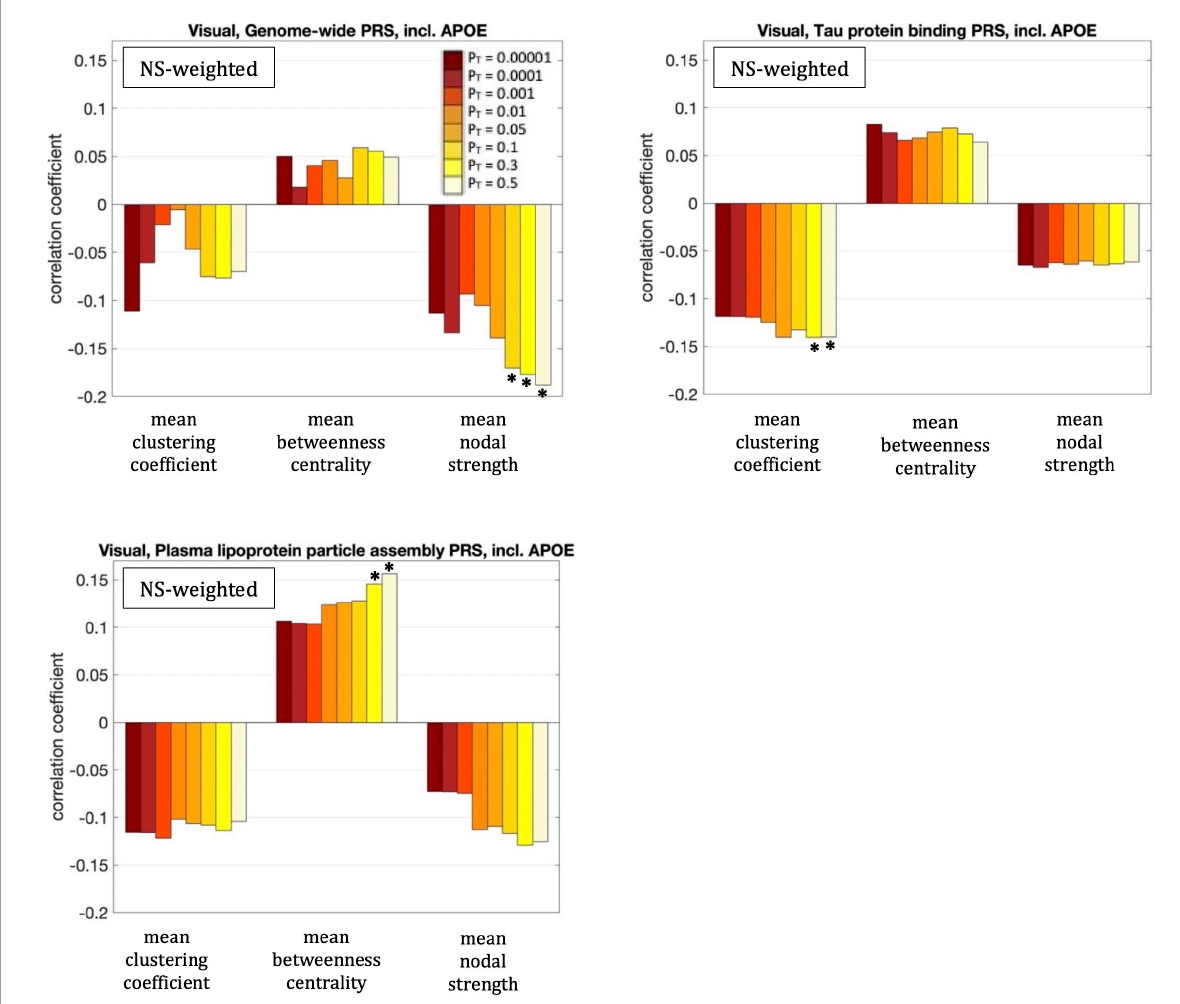
FIGURE6 Correlation coefficients between the graph theoretical metrics of the visual subnetwork and the three PRSs for which those survived multiple comparison correction, for the eight different values of P T . The asterisk indicates the instances in which the p -value survived multiple comparison